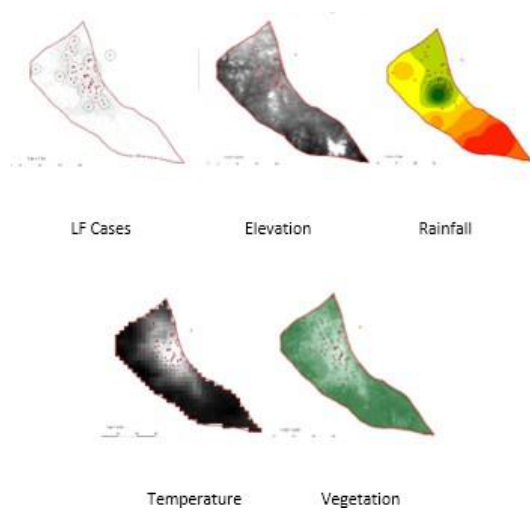
Figure 3. Raster layers used in the weight overlay analysis